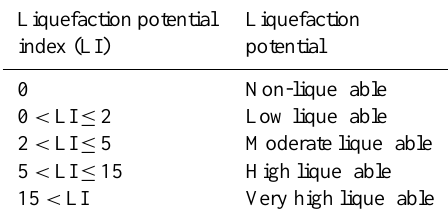
Table 2. Degrees of liquefaction potential (Sonmez,